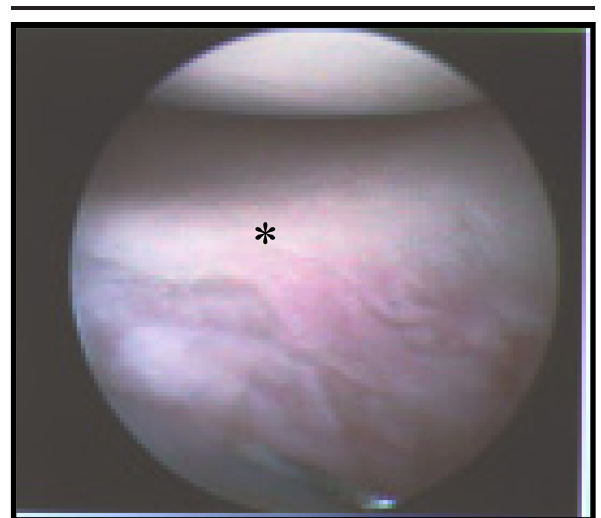
FIGURE 4 - Arthroscopic view of cartilage fibrilation (*) and chondromalacea (*) on the medial coronoid process of the ulna in elbow dog